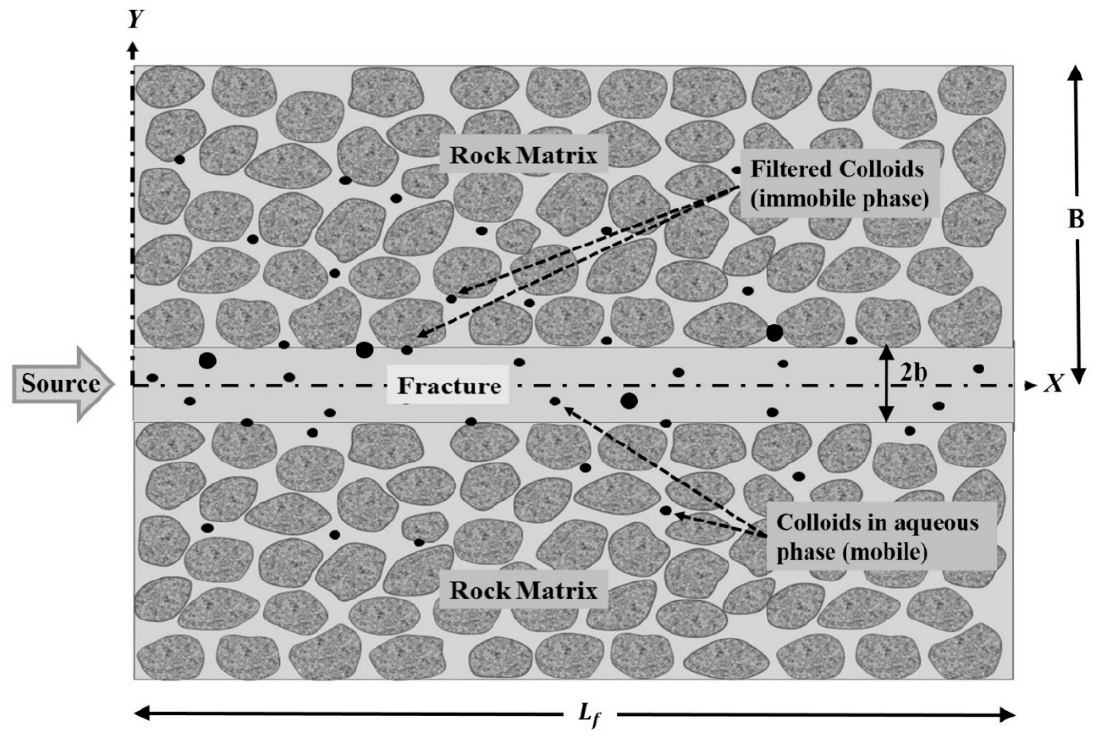
Figure 1. Conceptual model describing the cross-section of simplified single horizontal fracture surrounded by the porous rock matrix.